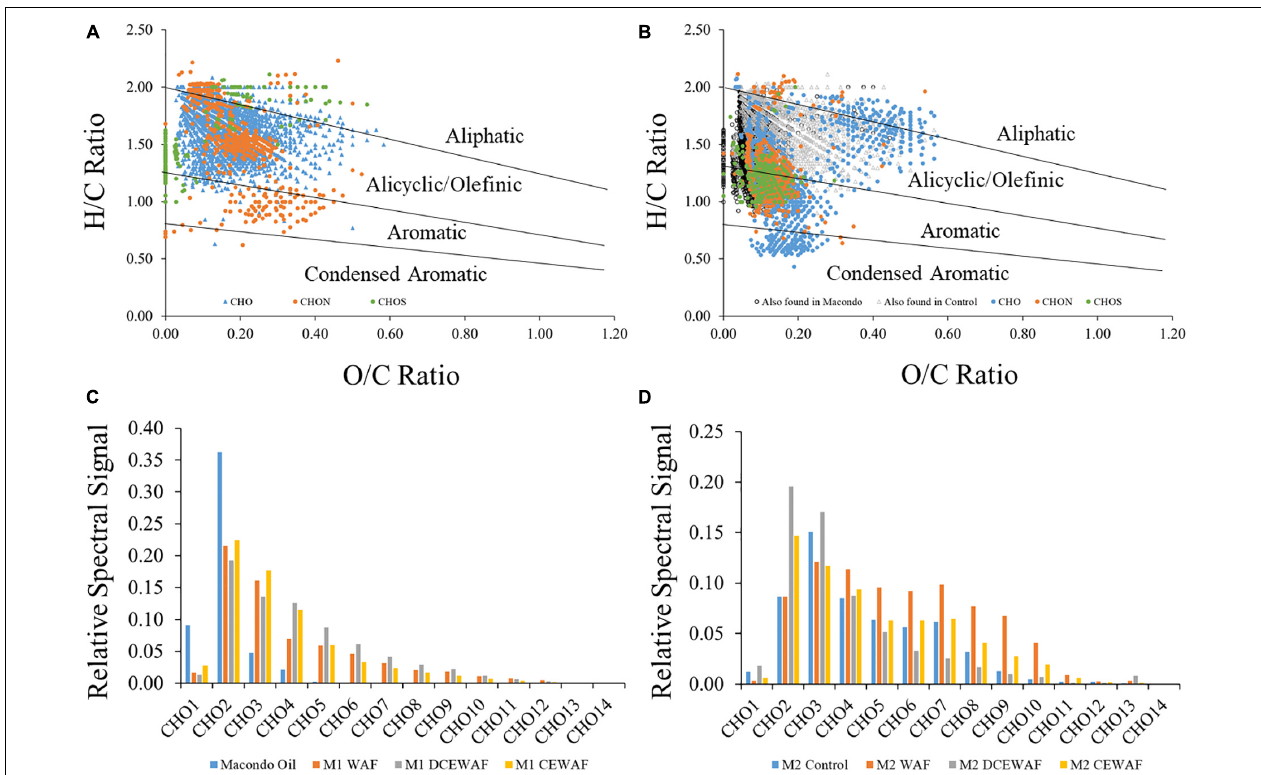
FIGURE 4 | Fourier Transform Ion Cyclotron Resonance Mass Spectrometry (FT-ICR-MS) data for dichloromethane extracts of sinking particles collected from the bottom of tanks in mesocosm treatments displayed as van Krevelen diagrams (A,B) for control (A) and diluted chemically-enhanced water accommodated fraction (DCEWAF) treatments (B) , and as isoabundance plots of oxygen (CHO 1 − 14 ) (C,D) for Macondo oil and Mesocosm 1 water accommodated fraction treatments (C) and Mesocosm 2 control and water accommodated treatments (D) . DCEWAF formulas also found in Macondo oil and the control treatments are noted as black circles and gray triangles, respectively, in panel (B) . Adapted from Wozniak et al.